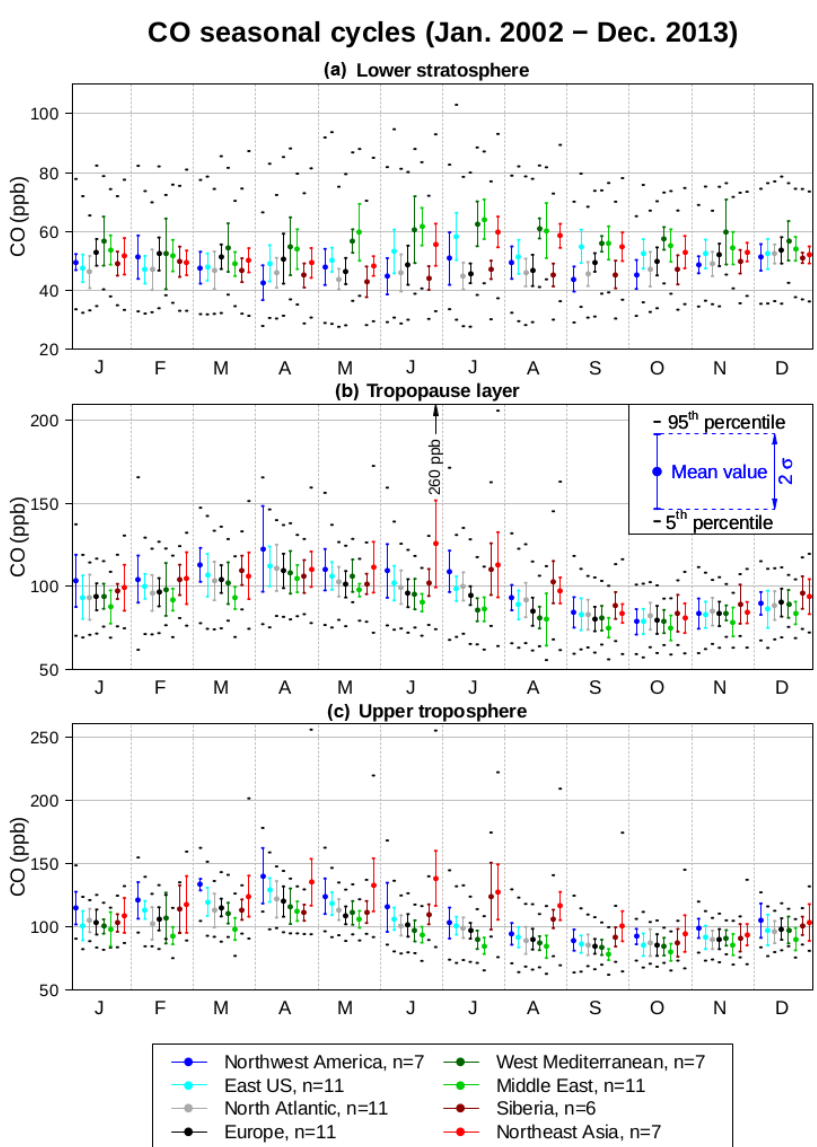
Figure 8. Seasonal cycles of CO for the monthly mean value (coloured points) and the 5th and 95th percentiles (lower and upper black ticks respectively). The interannual variability (coloured error bars) corresponds to the interannual standard deviation of the monthly mean value σ . From bottom to top, the graphs represent the cycles in the upper troposphere, tropopause layer, and lower stratosphere. The amount of years taken into account in the calculation of the upper-tropospheric CO cycles is indicated in the bottom legend as the number n